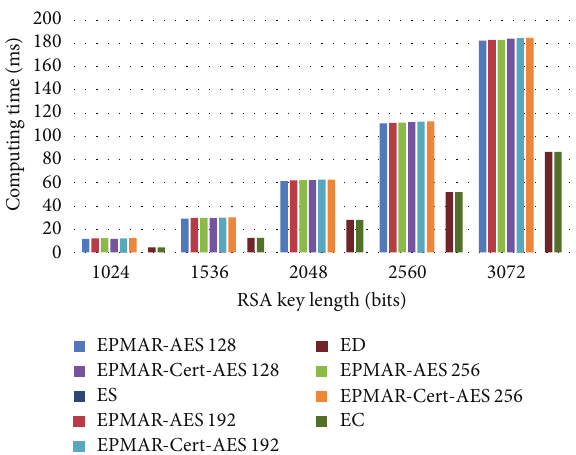
Figure 13: User phone’s computational loads—online transaction.